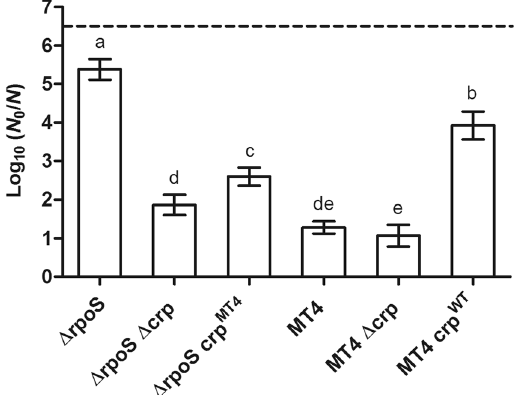
Figure 6. Logarithmic reduction factor of E. coli MG1655 ∆ rpoS equipped with a crp deletion ( ∆ rpoS ∆ crp ) or the crp allele from MT4 ( ∆ rpoS crp MT4 ), and MT4 equipped with a crp deletion (MT4 ∆ crp ) or the wild-type crp allele (MT4 crp WT ) by a HHP treatment at 500 MPa for 15 min. The dotted line represents the quantification limit (1,000 CFU/ml). Letters indicate statistically significant differences ( P ≤ 0.05) among the inactivation of all